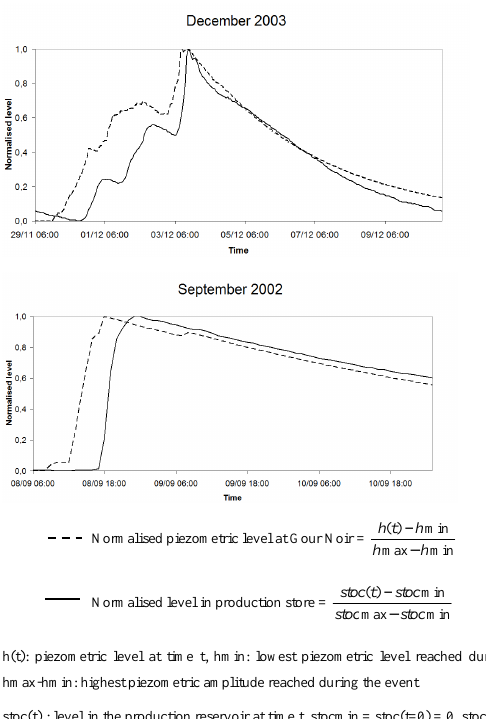
h(t): piezometric level at time t, hmin: lowest piezometric level reached during the event, 5 hmax-hmin: highest piezometric amplitude reached during the event 6 stoc(t) : level in the production reservoir at time t, stocmin = stoc(t=0) = 0, stocmax– stocmin: 7 highest level amplitude reached in the production reservoir during the event 8